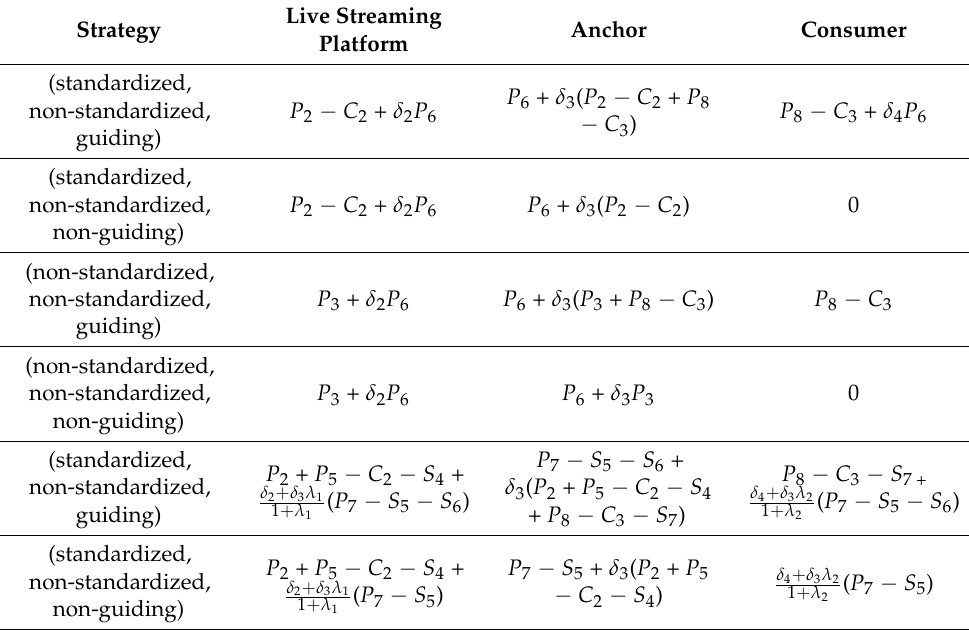
Table 12. The return and risk matrix of “network live streaming